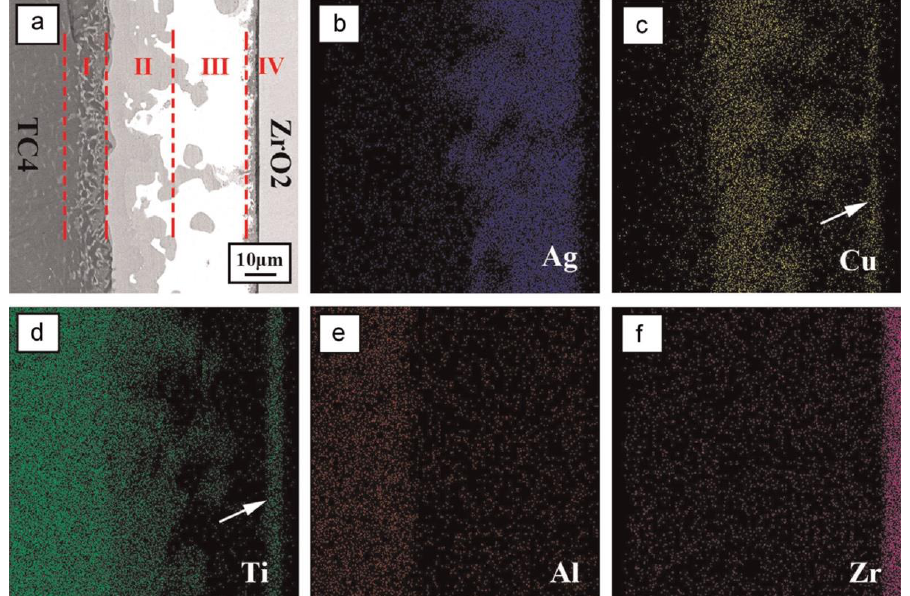
Figure 8. Microstructure and corresponding elements distribution of Ti6Al4V/ZrO 2 joint at 830 °C for 10 min: ( a ) Microstructure; ( b – f ) element maps distribution images of Ag, Cu, Ti, Al, V and Zr, reproduced from Reference [29] with permission of Elsevier, 2015.